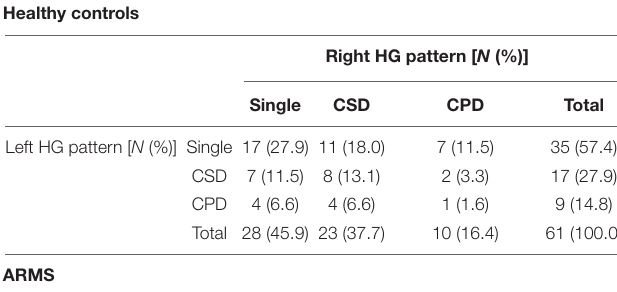
TABLE 2 | Gyrification pattern of Heschl’s gyrus (HG) in study participants. Healthy